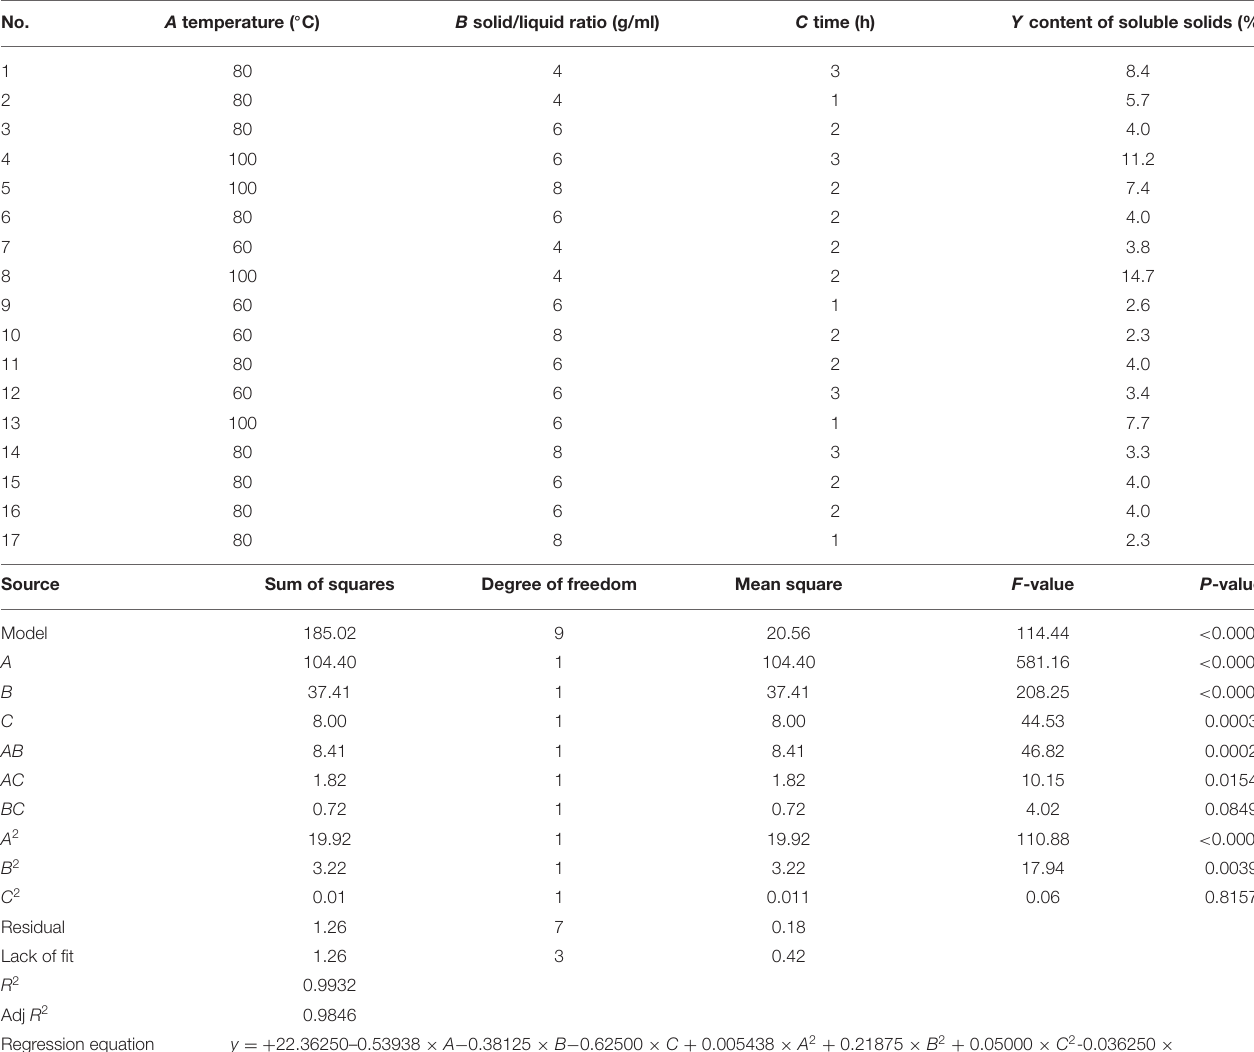
TABLE 1 | Box–Behnken experimental design and the effects of time, temperature, and solid-to-liquid ratio on hot water extraction of soluble solids from black garlic. No. A temperature ( ◦ C) B solid/liquid ratio (g/ml) C time (h) Y content of soluble solids